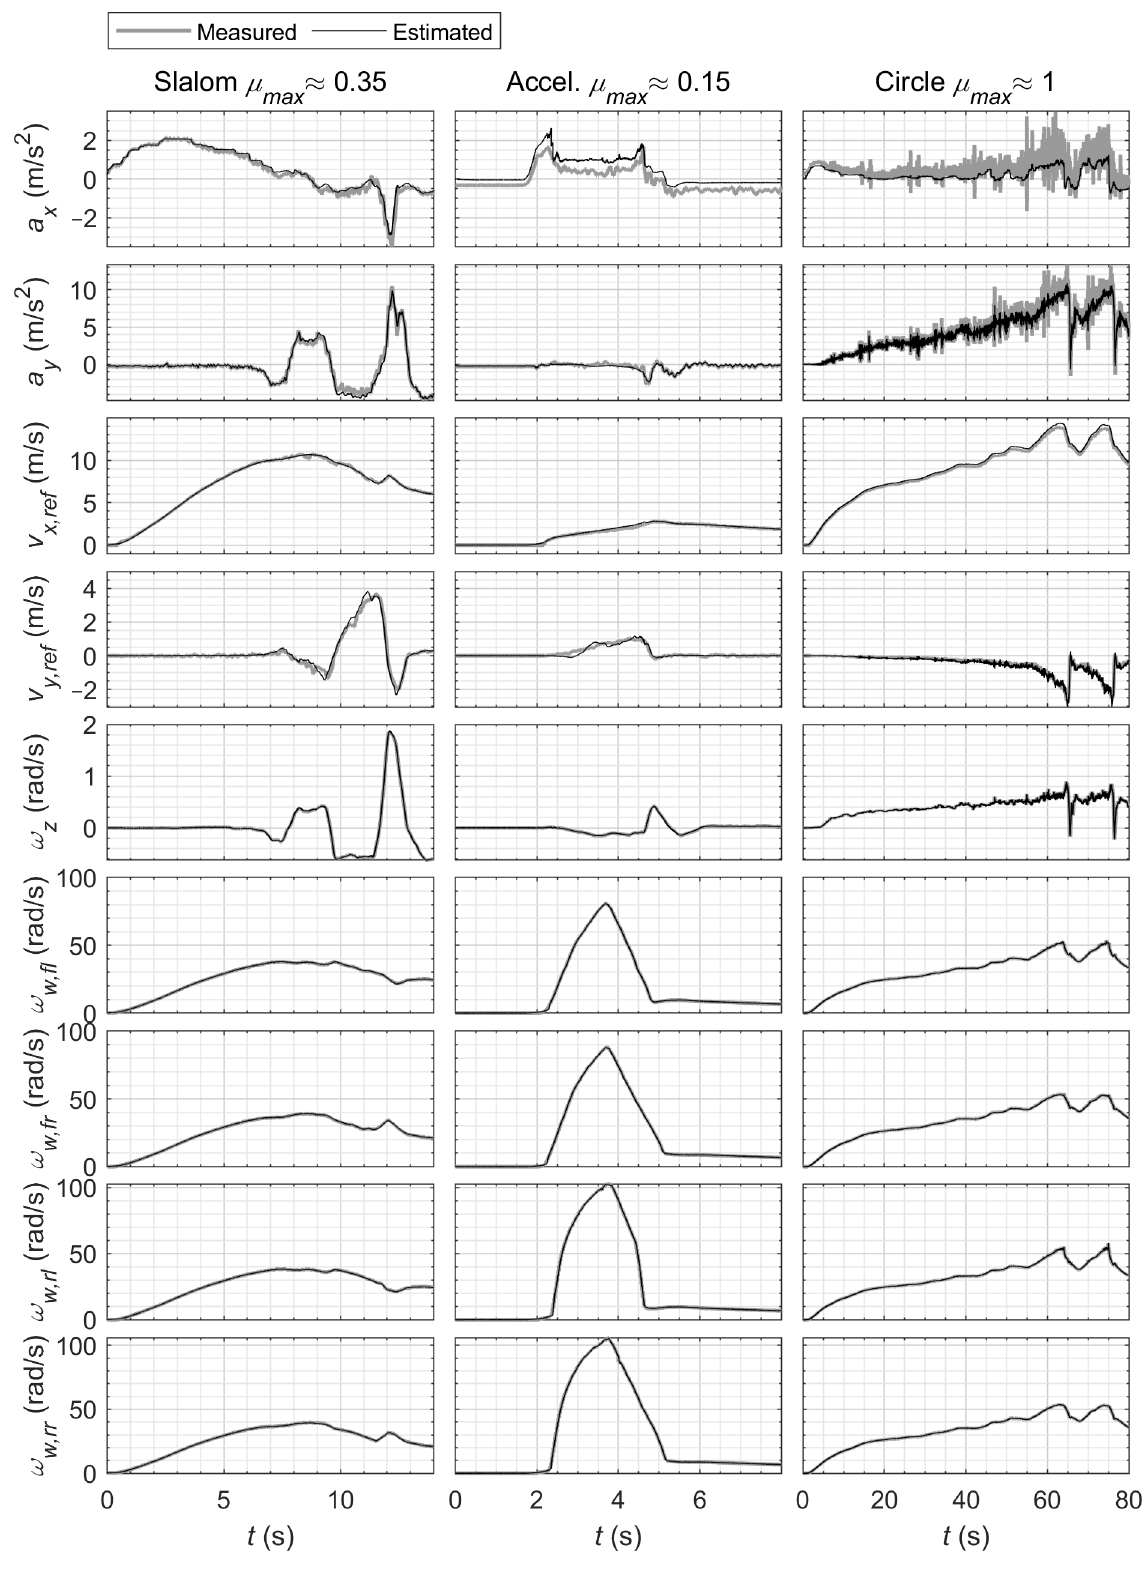
Figure A2. Training data: measured and estimated accelerations, velocities, yaw rate, and wheel